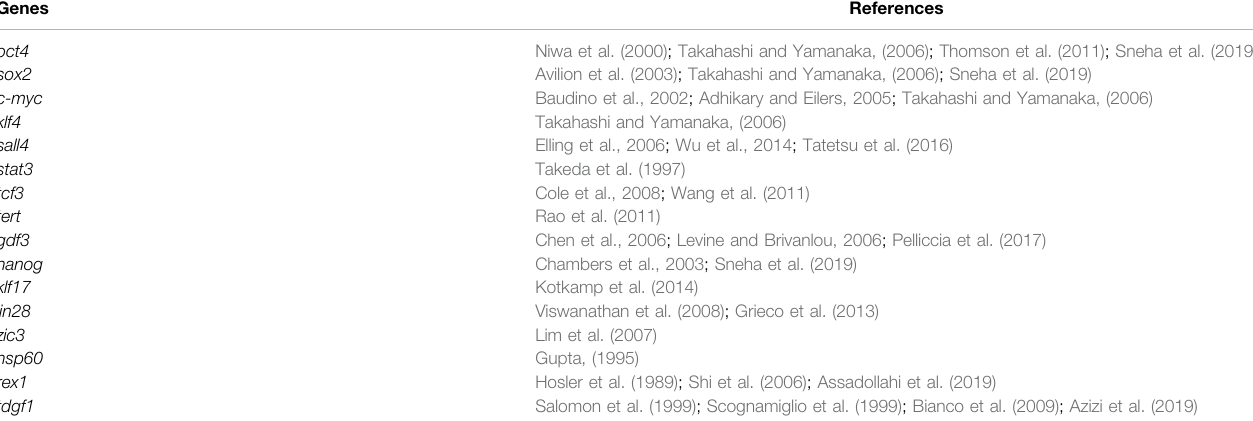
TABLE 1 | Listed of candidate pluripotency